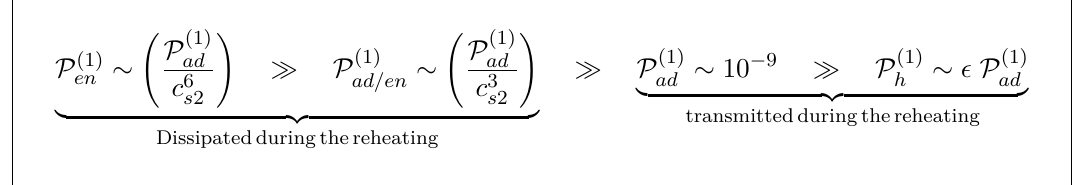
Table 4. Relations among power spectra (leading order) and their fate in a instantaneous reheating, in the limit c 1 s 2 (cid:28)